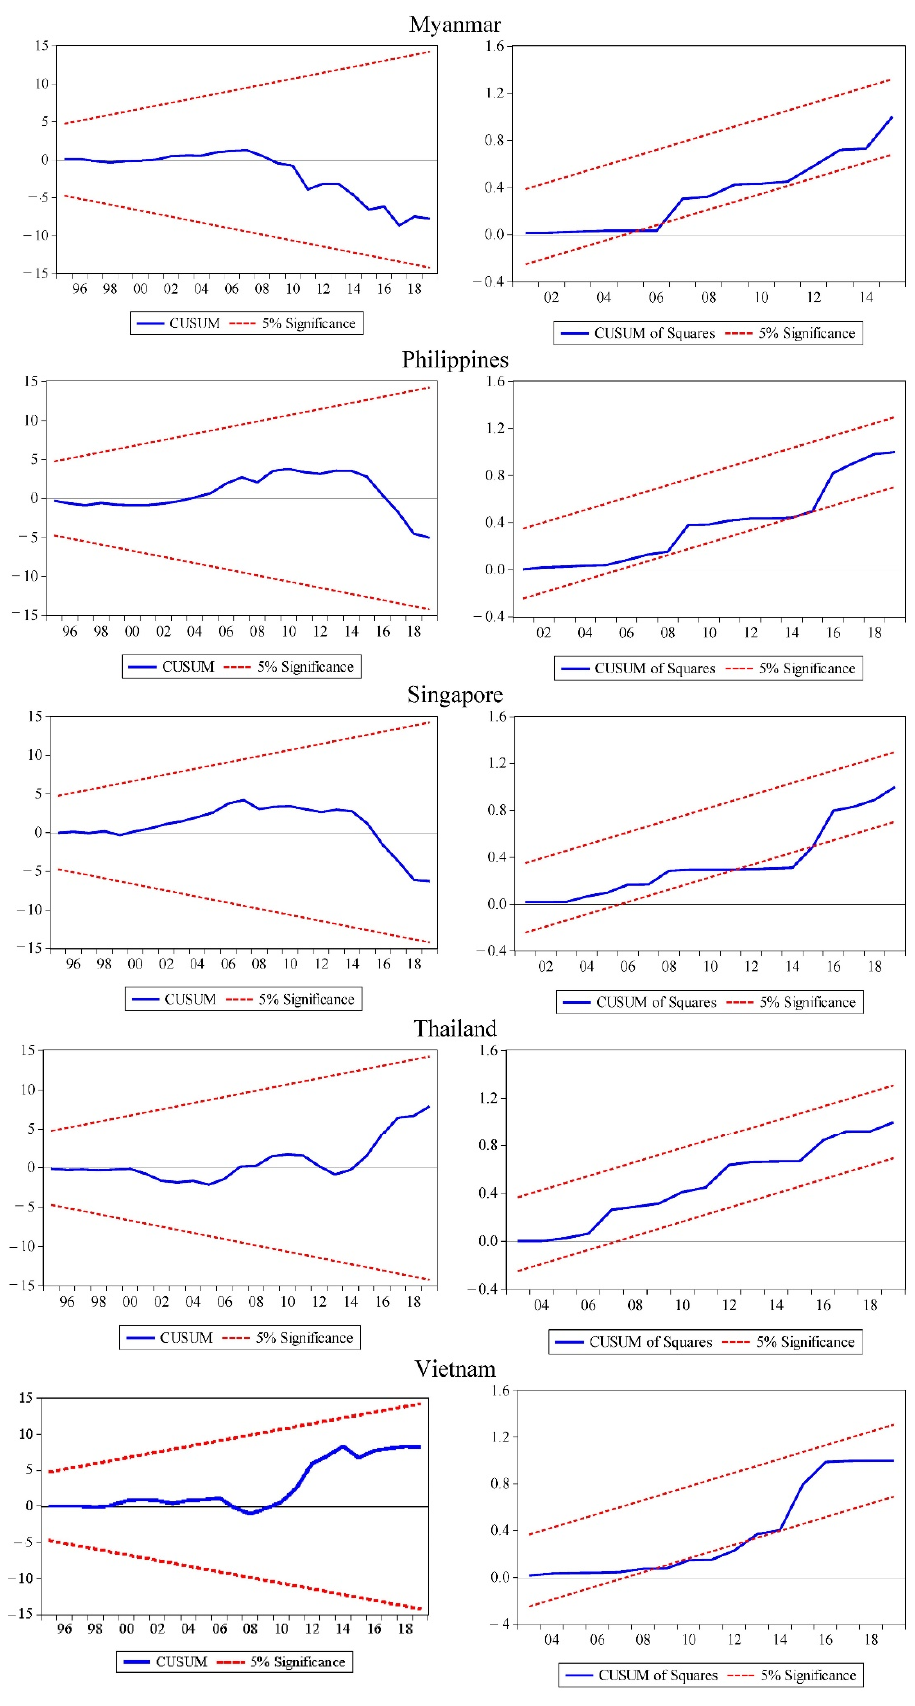
Figure 7. Findings of stability test (structural breaks and coefficient stability test) .